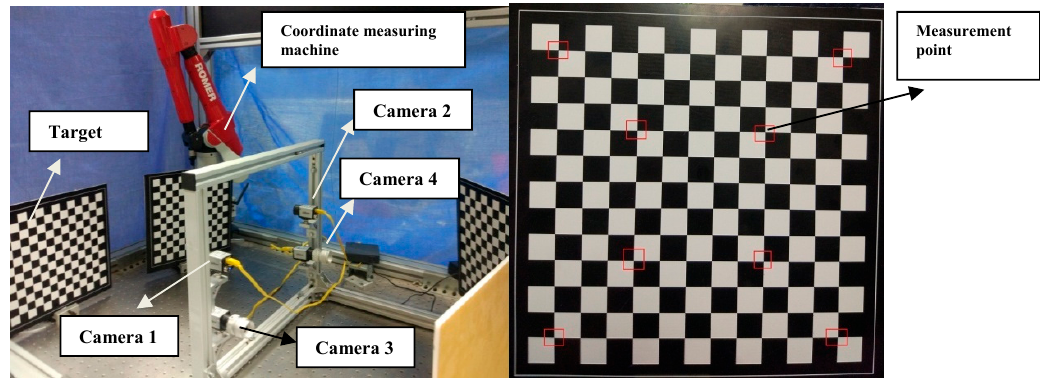
Figure 7. The left figure shows the experimental setup, and the right figure shows the measurement points marked by the red box on the target. points marked by the red box on the